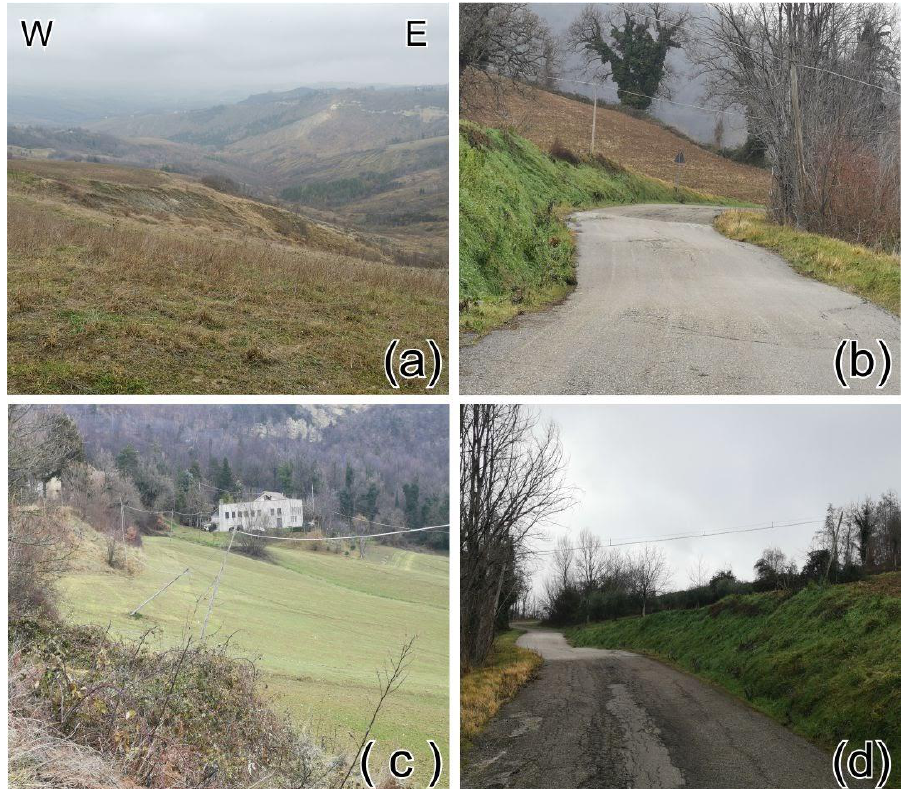
Figure 5. Typical landslides in the study area. ( a ) Rotational slide affecting clayey bedrock and ( b ) consequences on the road conditions; ( c ) example of earthflow involving fine slope deposits and ( d ) secondary road deformed by a landslide.